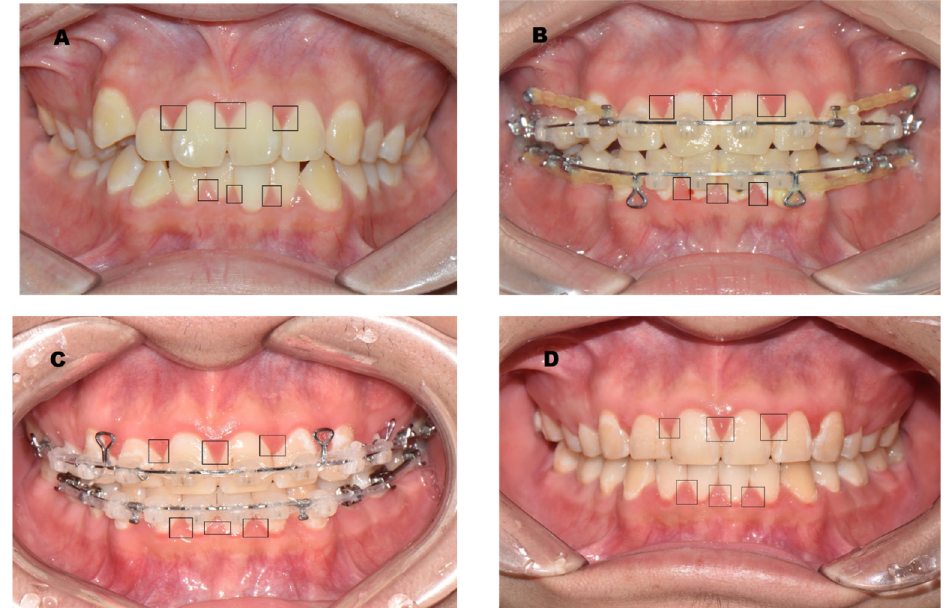
Figure 1. IOP showing the target gingiva: The lesions in the black squares in the IOP were papillary gingiva, which were selected and analyzed to measure redness. (( A ), BO, before orthodontic treatment; ( B ), MO, mid-point of orthodontic treatment; ( C ), TO, three-quarters of the way through orthodontic treatment; ( D ), IDO, immediately after debonding).